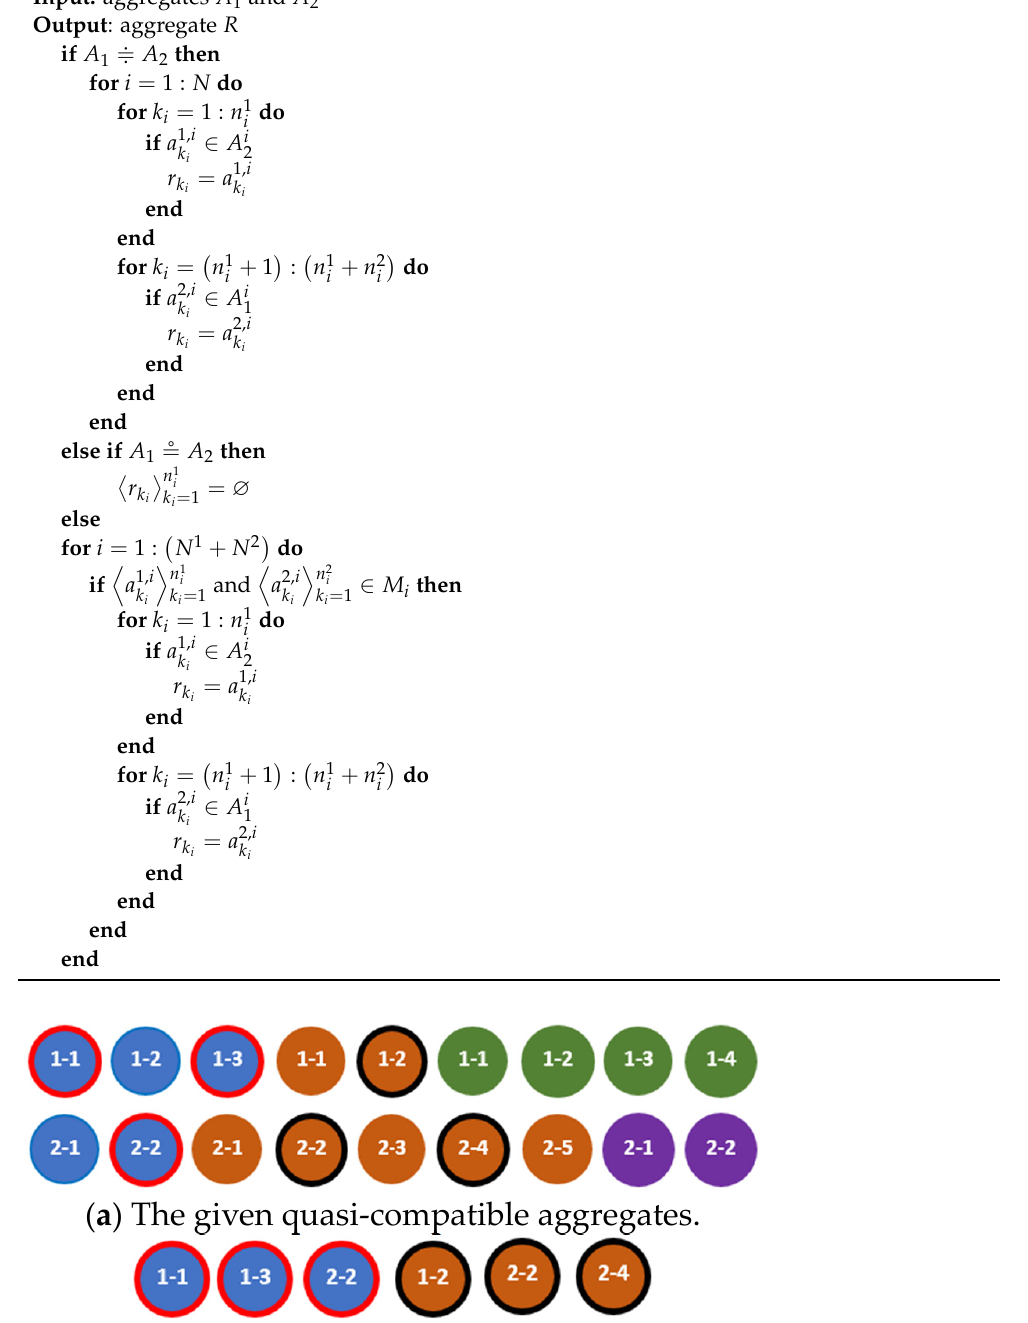
( a ) The given quasi-compatible aggregates.